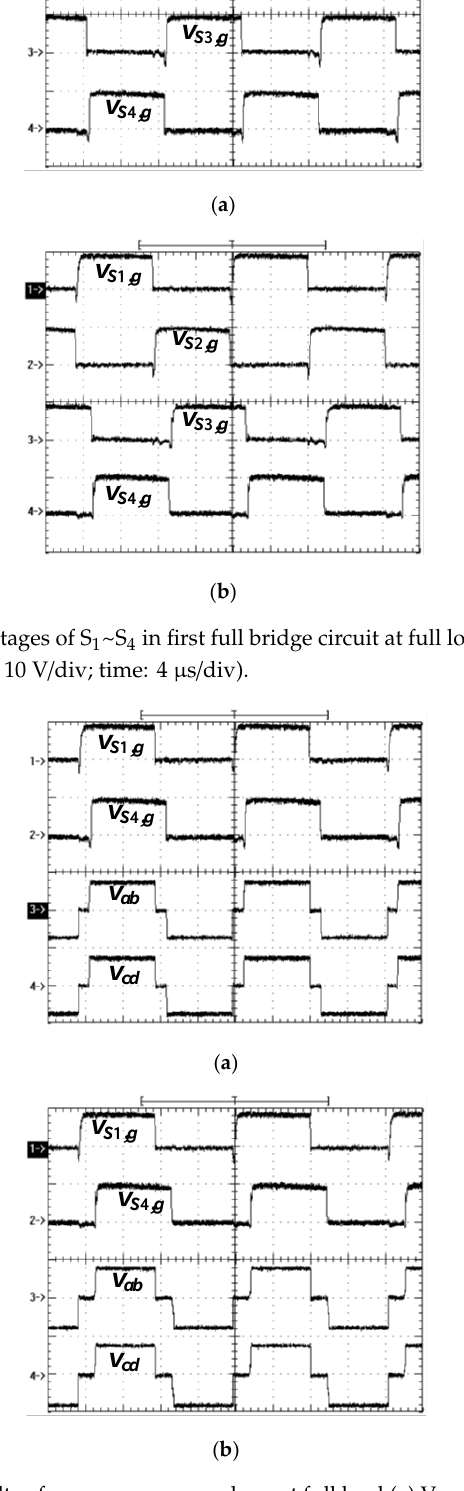
Figure 7. Experimental results of v S1,g , v S4,g , v ab and v cd at full load ( a ) V in = 750 V and ( b ) V in = 800 V (v S1,g , v S4,g : 10 V / div; v ab , v cd : 500 V / div; time: 4 µ s /